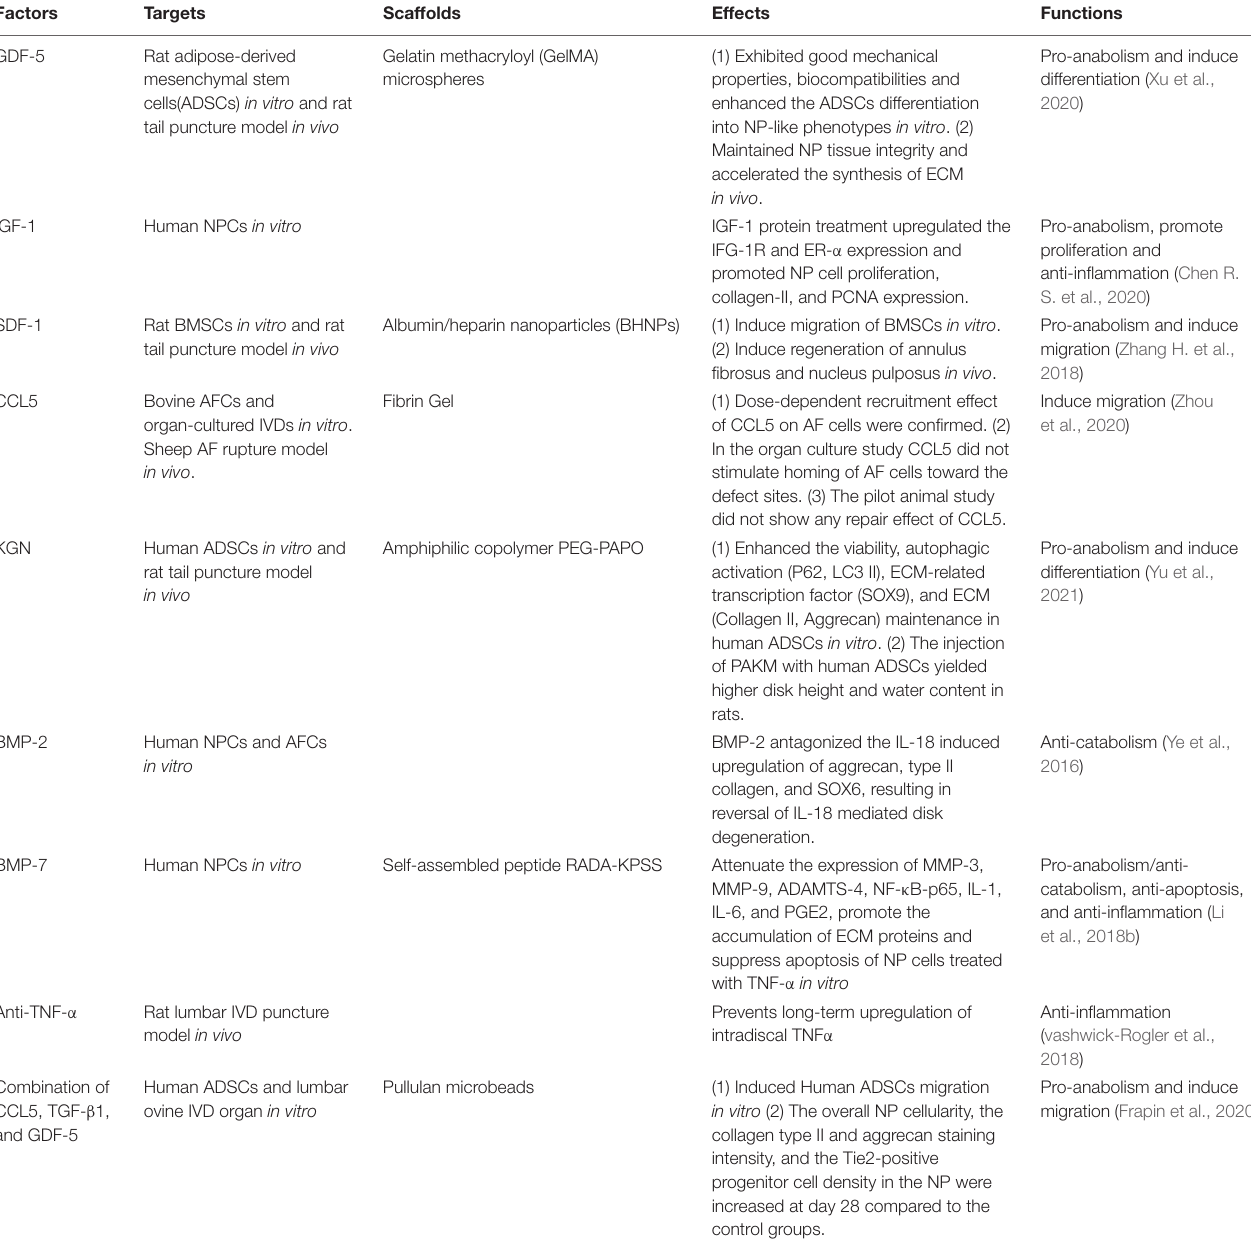
TABLE 1 | Several widely used therapeutic biological